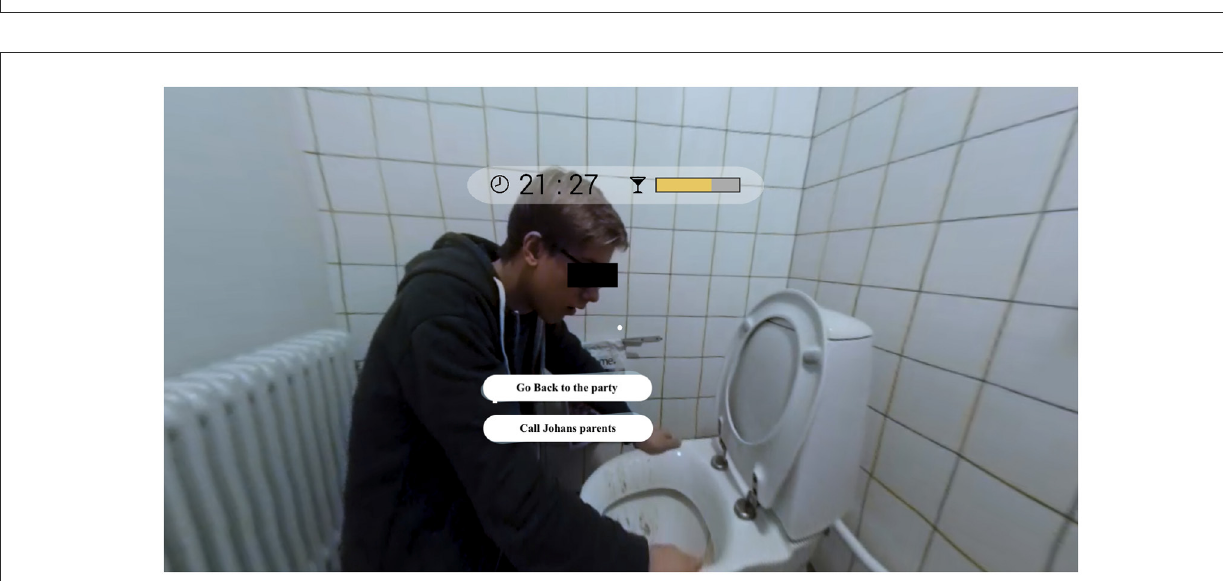
FIGURE1 Screenshot of the VR simulation in which the user is asked what they would like to drink text translated to English.